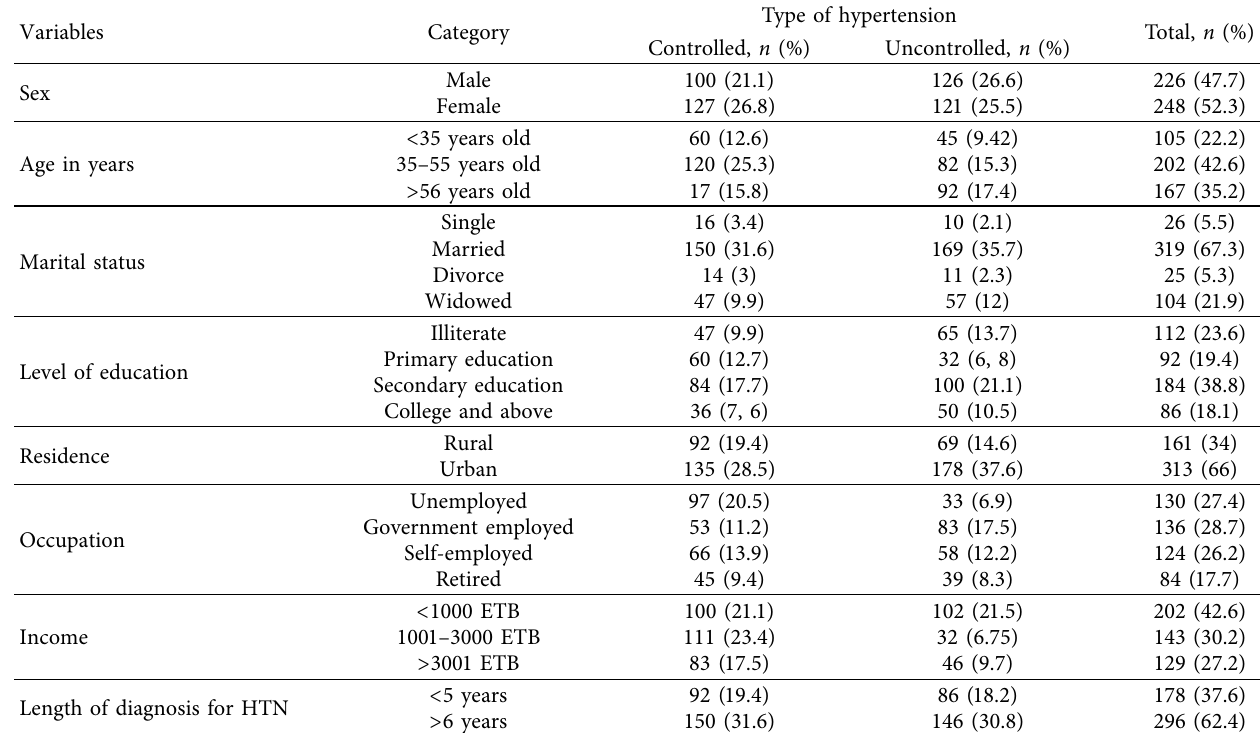
Table 1: Sociodemographic characteristics of hypertensive patients who were attending St. Paul’s Hospital, Millennium Medical College, Addis Ababa, Ethiopia, 2020 ( n �